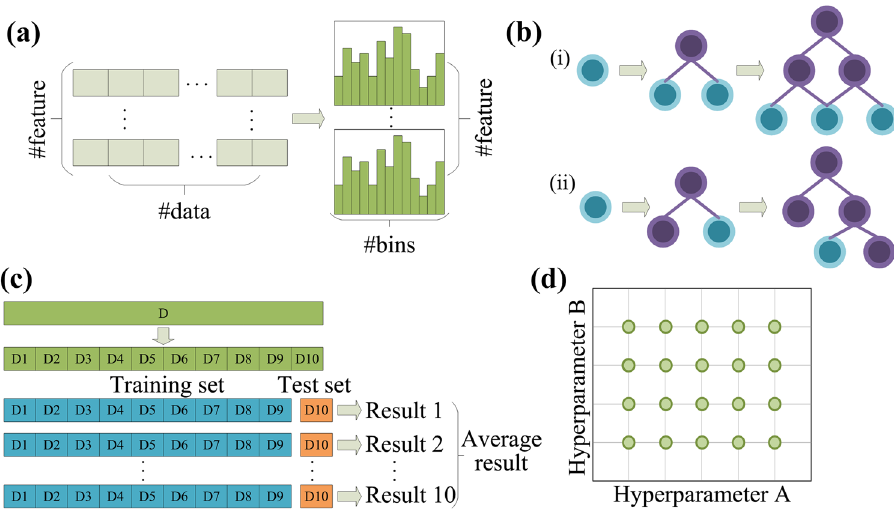
Fig. 2 The features of light gradient boosting